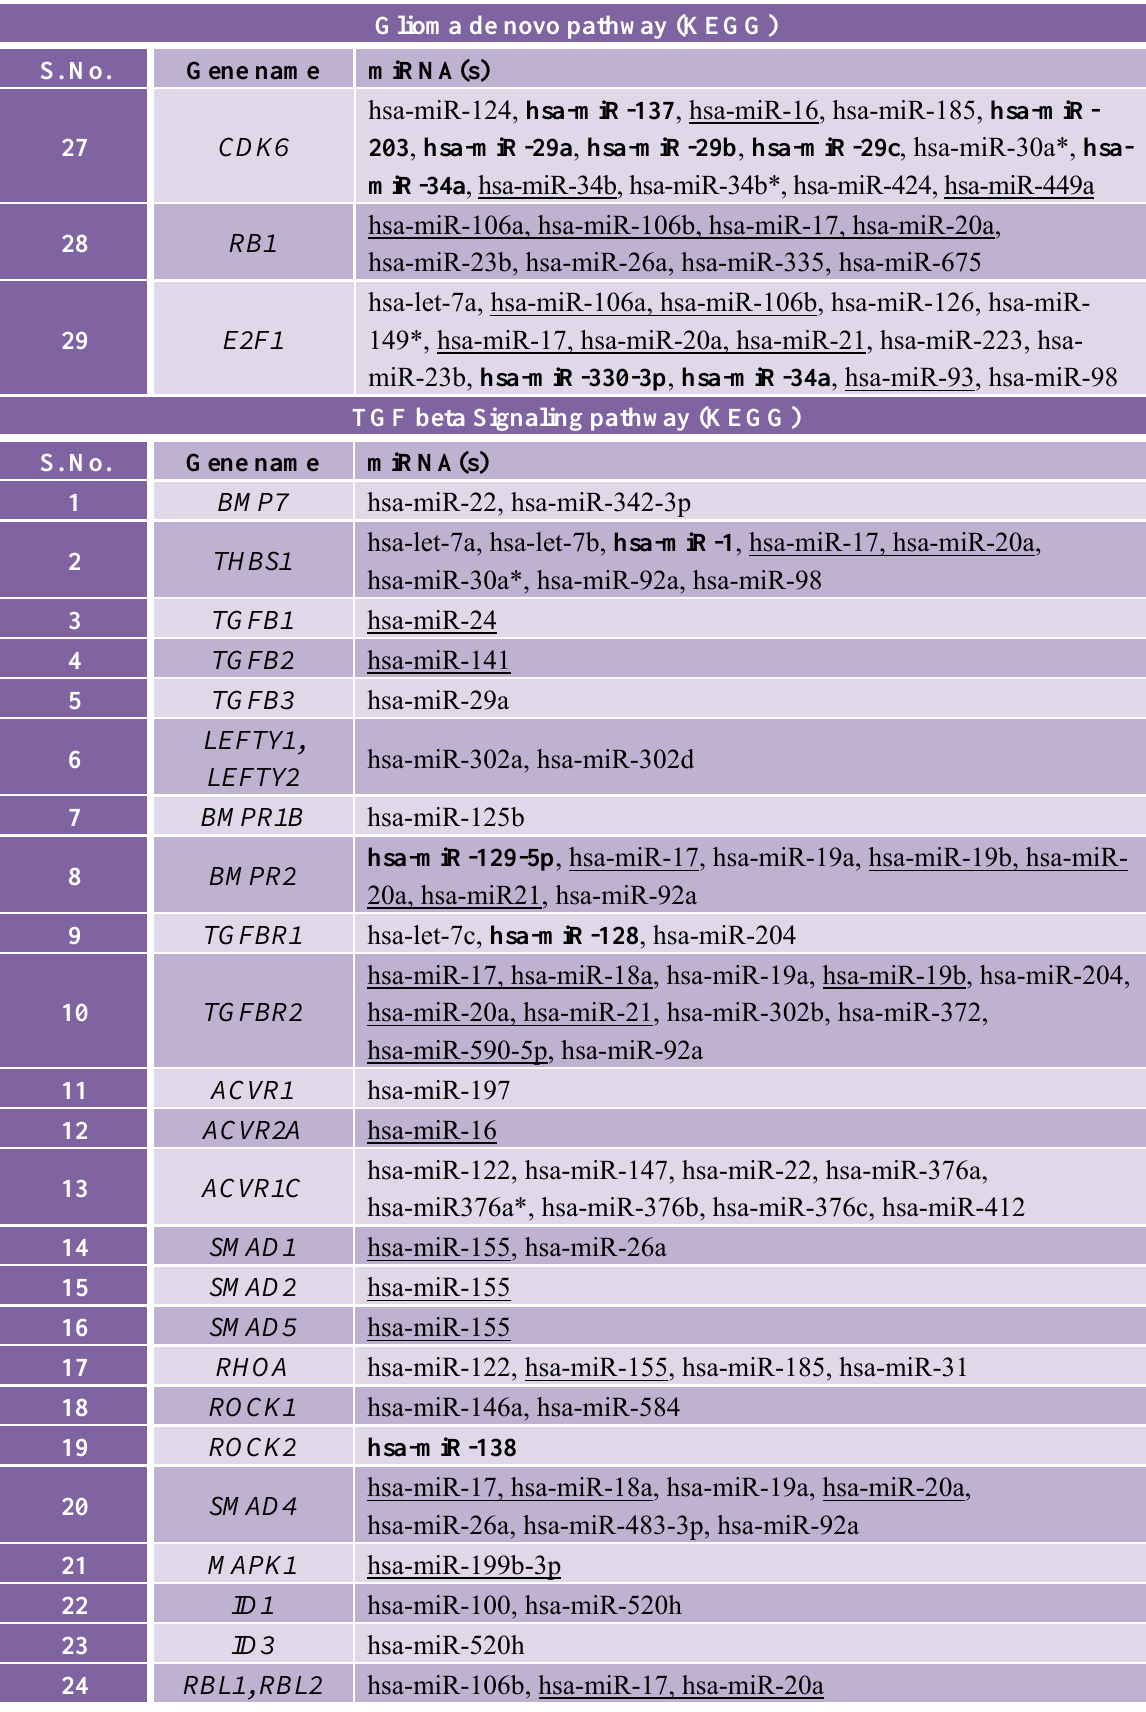
Table 2. Cont . Glioma de novo pathway